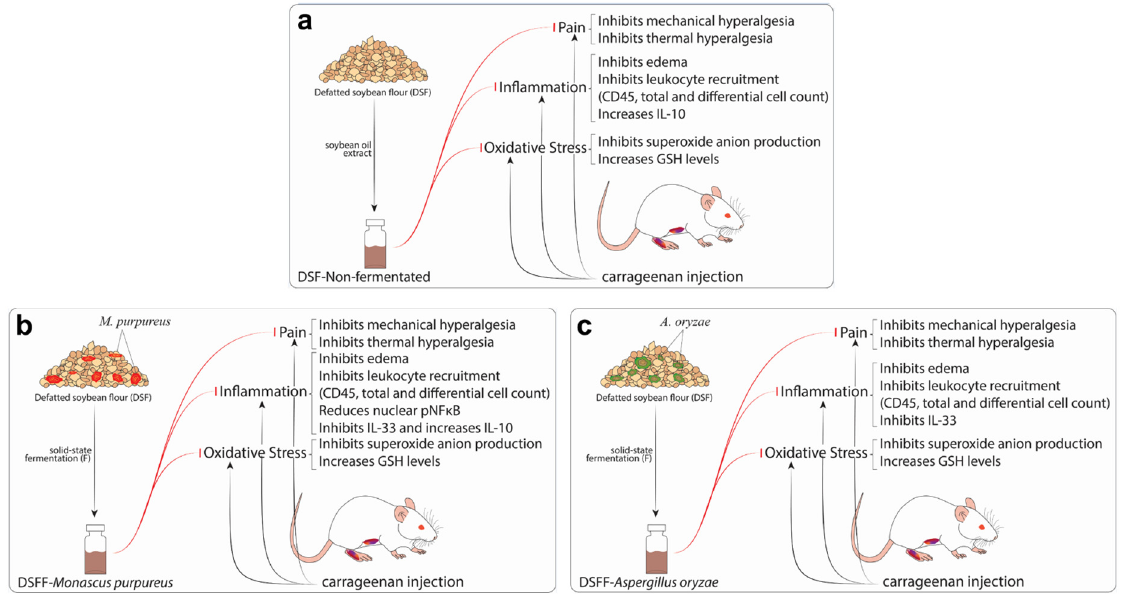
Figure 8. Schematic representation of the effects of DSF non-fermented and fungi-fermented extracts evaluated in the present study. ( a ) DSF-Non, ( b ) DSFF-Mp, and ( c ) DSFF-Ao.